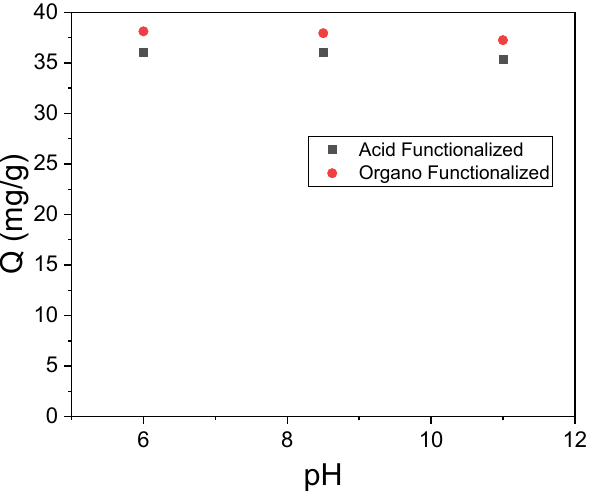
Figure 5. Effect of pH on the adsorption of SD by acid and organo-functionalized clays (m = 0.05 g, T = 25 °C and C i = 50 mg L −1 ).